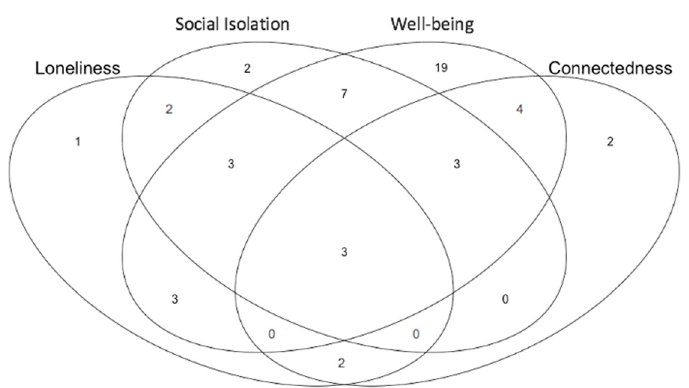
Figure 3. Venn diagram of the 51 papers according to which outcomes they address of the 4 key concepts that are the focus of this systematic review: loneliness, social isolation, well-being, and connectedness.